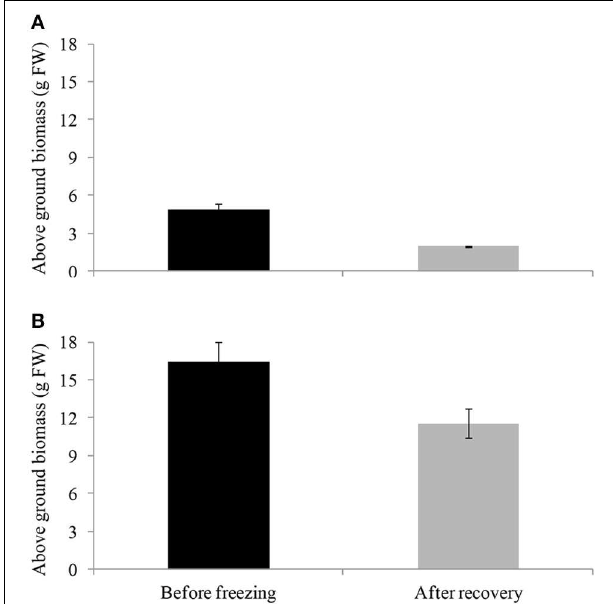
FIGURE 3 | Recovery of cold-acclimated perennial ryegrass ( Lolium perenne L.) variety “Veyo” and ecotype “Falster” after freezing. Fresh weight of above ground biomass before freezing and after 7 d of recovery from freezing ( − 10 ◦ C for 3h) in (A) “Veyo” and (B) “Falster.” Data represent the mean ± SE, obtained from three biological replicates of the